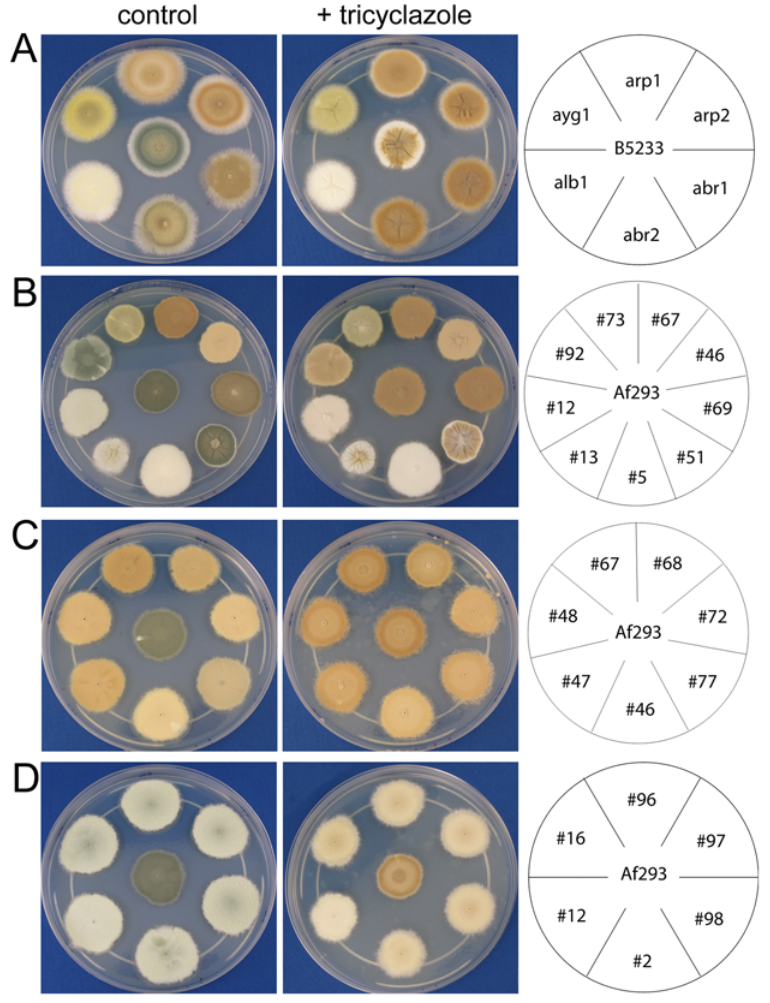
Figure 5. Tricyclazole sensitivity of selected A.fumigatus color mutants in the Af293 background and previously defined color mutants in the B5233 background. Images of A. fumigatus on YNB agar medium with and without tricyclazole after 3 days of growth at 30 u C. ( A ) Wild type A. fumigatus strain B5233 and previously defined color mutants alb1 , ayg1 , arp1 , arp2 , abr1 , and abr2 ; ( B ) wild type A. fumigatus strain Af293 and selected color mutant strains # 5, # 12, # 13, # 46, # 51, # 67, # 69, # 73, and # 92 in the Af293 background; ( C ) brown color mutants # 46, # 47, # 48, # 67, # 68, # 72, and # 77 in the Af293 background, and ( D ) light turquoise color mutants # 2, # 12, # 16, # 96, # 97, and # 98 in the Af293 background with and without tricyclazole present in agar medium.